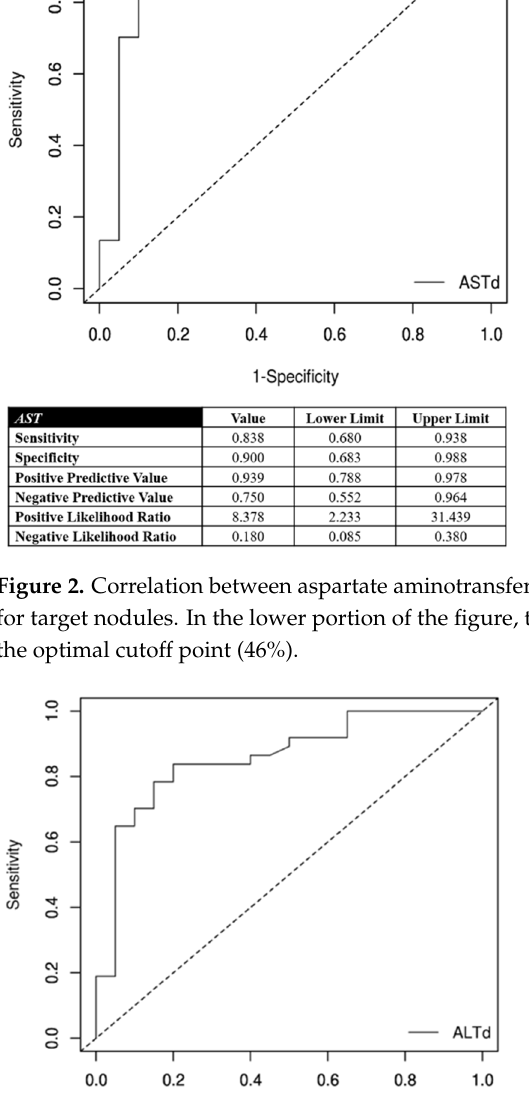
Table 3. Univariate and multivariate logistic regression analyses for the assessment of clinical, la- boratory, and procedural data associated with objective response when considering only the re- sponse of the target lesions (lesions treated with conventional chemoembolization). .